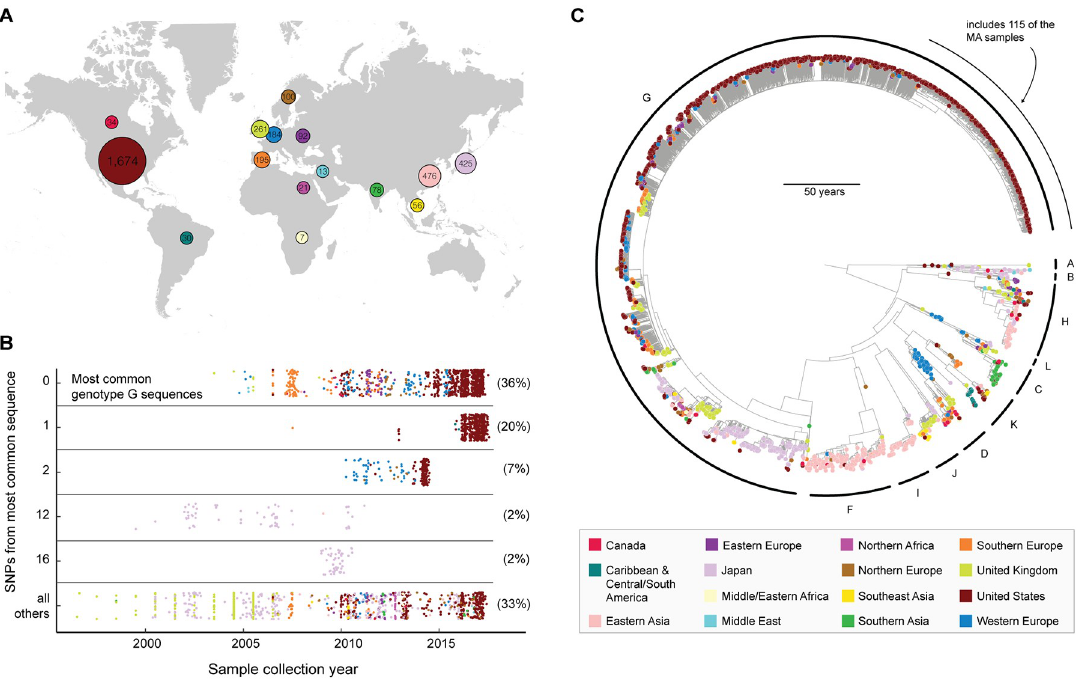
Fig 3. Global spread of mumps virus based on SH gene sequences. Colors in all panels are by region (legend in bottom right). (A) Number of SH sequences in our data set from each of the 15 regions. (B) Identical genotype G sequences over time from 1995 through 2017. Each dot represents a sample; each row contains samples with identical SH sequences, except the bottom, which includes samples with sequences distinct from those in the above 5 categories. Numbers on the right: percentage of all genotype G samples found in that row. (C) Maximum clade credibility tree of 3,646 publicly available SH gene sequences, including 193 complete SH sequences generated in this study. SH, small hydrophobic.